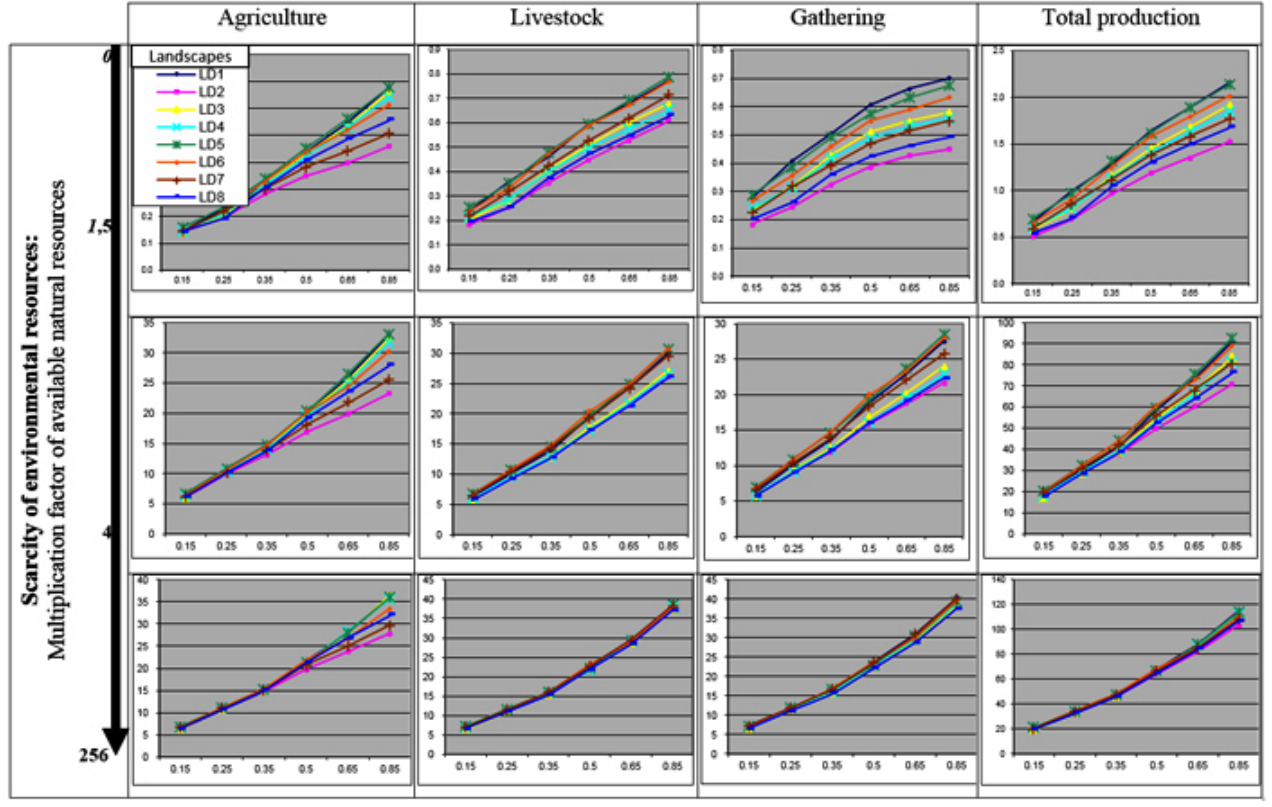
Fig. 9 . Variations in landscape production (y-axis: productivity units), as a function of land use, user density (x-axis), and the scarcity of environmental resources. Because the x axis represents increasing user density in the computer model, looking at the curves from left to right, one can monitor the effect of increasing user density on the productivity of each local area. The local areas are the eight subdivisions of a board map (Fig. 2). Productivity increases with an increase in user density, as shown by the individual graphs from left to right, because more users exploit available resources, and overall the curves increase. However, some graphs show a local area with weaker growth. From top to bottom, the graphs are arranged according to the different natural resource parameters applied during the simulation. The worst environmental conditions are in the top graphs. Thus environmental scarcity decreases from top to bottom, see the arrow on the left side of the chart. First, one can see that when environmental conditions worsen, i.e., from the bottom to the top graphs, the differences between the landscapes become greater. Moreover, in these conditions of resource scarcity, depending on the activity, the same landscape will not always be the most advantageous (see colored curves). More generally, the diversity of the landscape curves presented underlines the fact that the advantageous features of a particular landscape at a particular time are the result of a complex combination of factors that changes as a function of each different combination of scarcity, land uses, and user